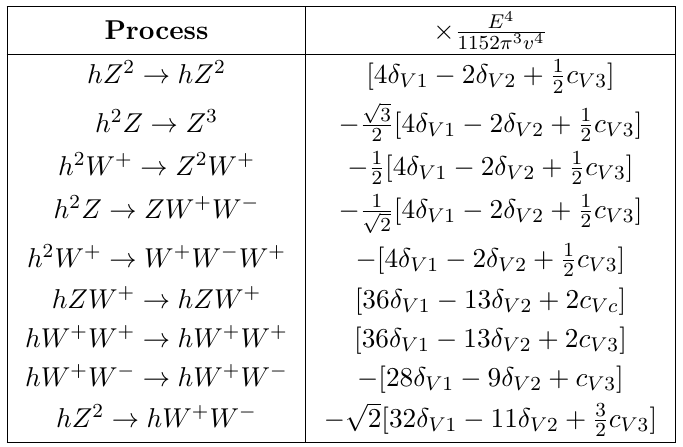
Table 5 . 6-body unitarity-violating processes that depend on δ V 1 , δ V 2 , and c V 3 . One can see that the dim-6 SMEFT prediction δ processes.